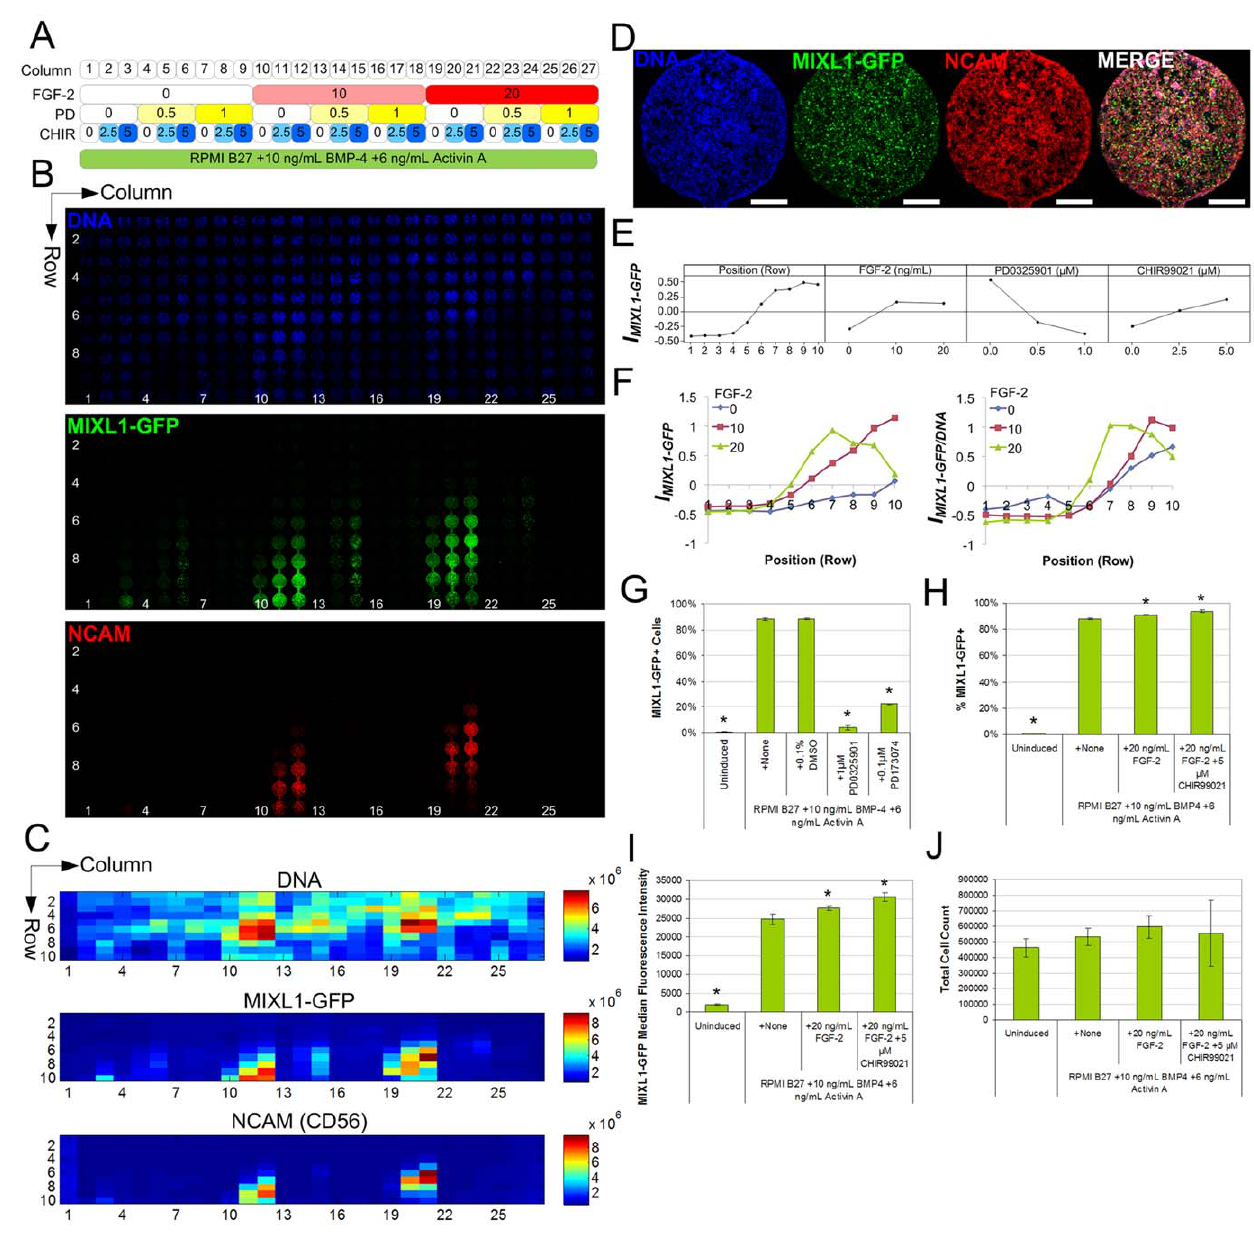
Figure 4. Interrogation of FGF stimulation and MEK inhibition on hESC mesendodermal differentiation in HES3( MIXL1 GFP/w ) hESCs. A Screening panel showing array conditions. Numbers indicate concentrations of FGF-2 (ng/mL), PD0325901 (PD; m M), and CHIR99021 (CHIR; m M). B Confocal tile scan image of HES3( MIXL1 GFP/w ) hESCs expressing GFP and and co-immunostained in situ for NCAM (CD56) and Hoechst at 2.5 d experiment endpoint. Flow direction was from top to bottom. C Heatmaps of total fluorescence intensities in the array (arbitrary units). D Higher- magnification images of cells in highest MIXL1-expressing conditions – Column 21, Row 7– demonstrating efficient induction of MIXL1-GFP and NCAM. Scale bar: 500 m m. E Main effect magnitudes of factors on expression index I MIXL1-GFP . Units represent global standard deviations relative to global mean. F Selected interaction effect plots showing average effect magnitudes for combinations of FGF-2 and Position on expression index I MIXL1-GFP and DNA-normalised expression index I MIXL1-GFP/DNA , highlighting the shift towards earlier rows with FGF-2 treatment (legend represents FGF- 2 concentration in ng/mL). G Chemical inhibition of MIXL1-GFP induction with MEK cascade inhibitor PD0325901 and FGF receptor tyrosine kinase inhibitor PD173074. Bars represent mean 6 s.d., n =2 2 3 from one representative experiment. H-J Addition of FGF-2 or FGF-2 + CHIR99021 improved induction efficiency ( H ) and median fluorescence intensity ( I ) in static controls, but without significantly increasing total cell count ( J ). Bars represent mean 6 s.d., n =4 from 2 independent experiments. * p , 0.05 compared to + None condition, one-way ANOVA. doi:10.1371/journal.pone.0052405.g004 with the timing of expression of primitive streak markers MIXL1 at GSK-3 b to activate b -catenin-mediated canonical Wnt and T . It has further been reported that Wnt3a-stimulated mouse signalling, their effect should be immune to the inhibitory effect ES cells form T + PS and activate a negative feedback loop of paracrine DKK1 (which binds to the Wnt co-receptor LRP5/6) mediated by Dkk-1 [31]. Since BIO and CHIR act intracellularly